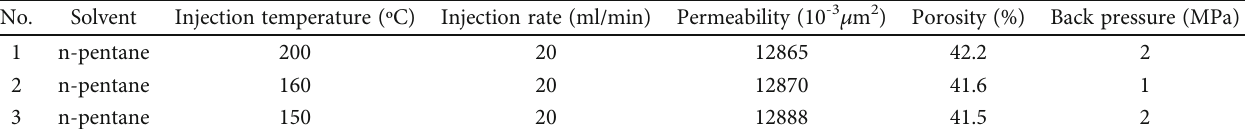
Table 2: Injection parameters of 3D